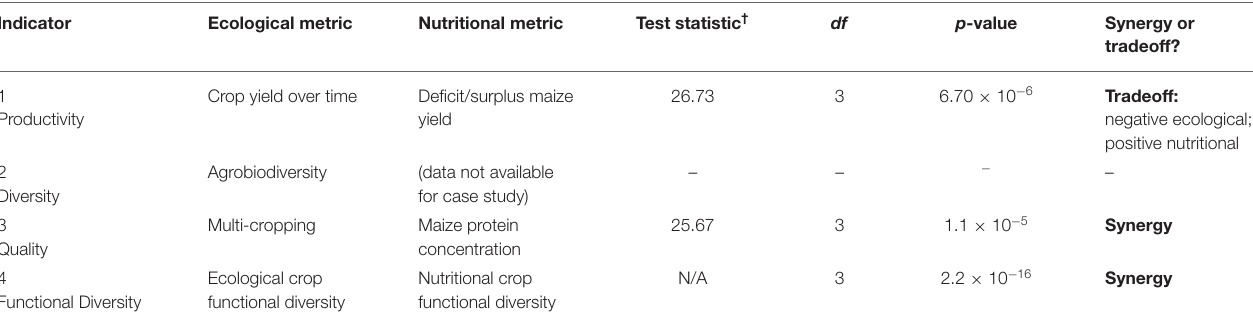
TABLE 3 | Results of contingency analysis between individual pairs of ecological and nutritional indicators, representing tradeoffs or synergies, across all farms ( n = 60) in a case study in eastern Guatemala. Indicator